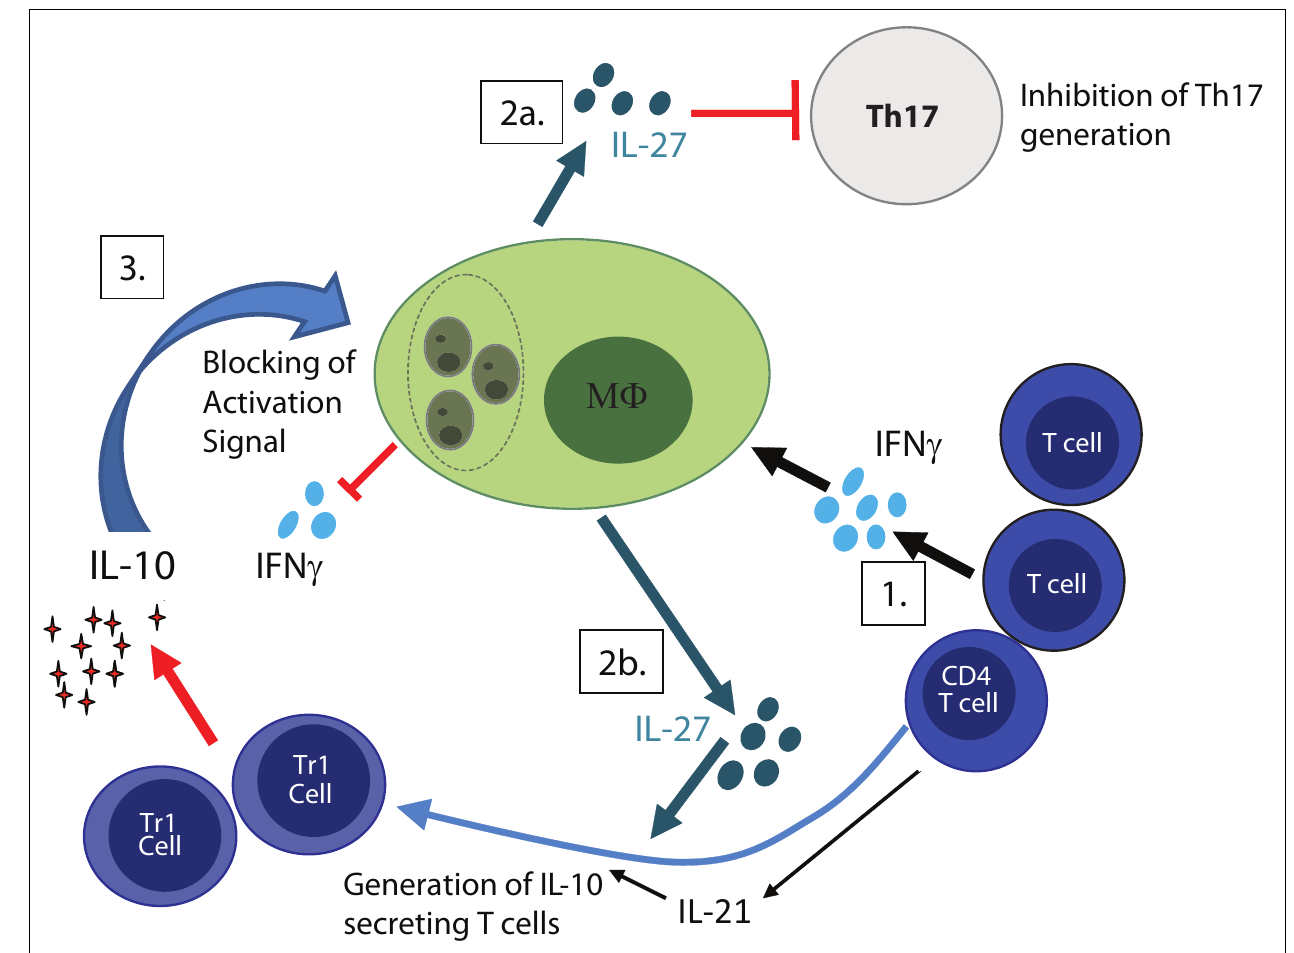
FIGURE 1 | Regulatory feedback loop facilitate parasite persistence. (1) ActivatedT cells both CD4 and CD8 produce IFN γ , which in combination with IL-1 β drives IL-27 production by macrophages. (2a) IL-27 inhibits generation of potentially protectiveTh17 cells and (2b) promotes together with IL-21 the